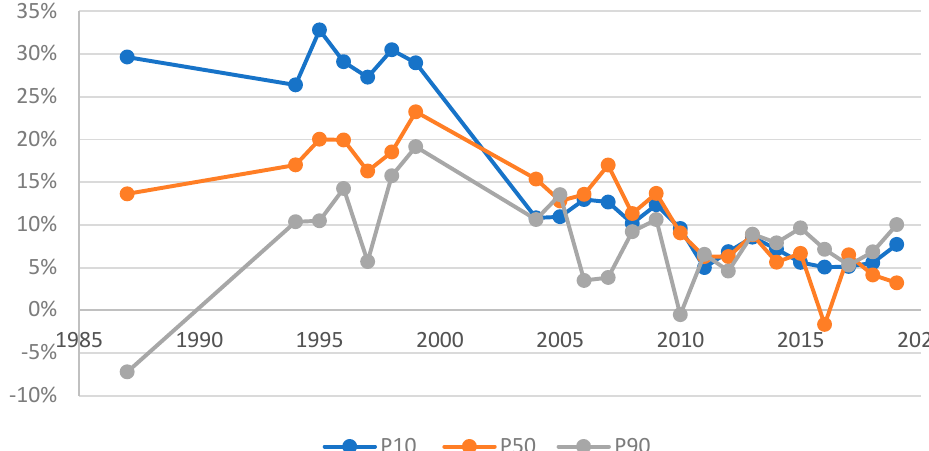
Figure 4. The gender wage gap at selected percentiles. Source: Authors’ calculations using the ESRI Survey of Income Distribution, Poverty and Usage of State Services and the European Union—Survey of Income and Living Conditions. Notes: Limited to respondents aged 25–55 and excluding the self-employed. Wages are CPI adjusted and weighted.